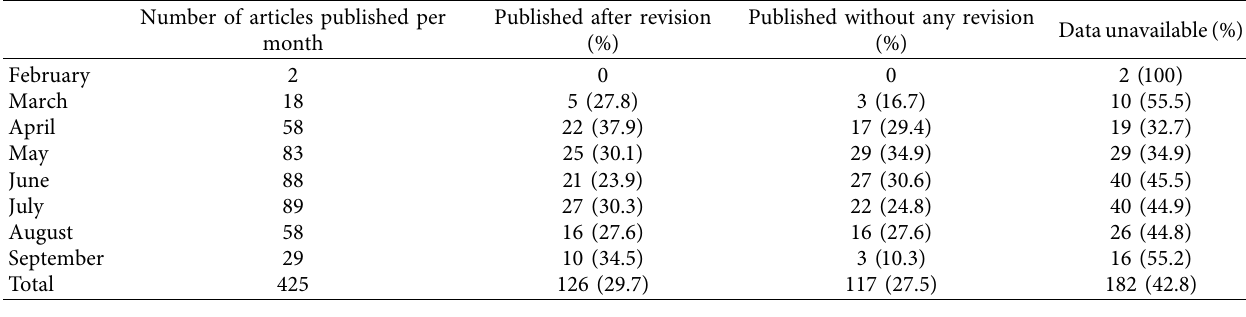
Figure 1: Time course of the mean ± SD interval (in days) between the initial submission and acceptance, by month of publication. Number of publications with available data added besides each time point. Table 1: Summary of the articles published without revision and articles published with at least one revision, by month of publication.